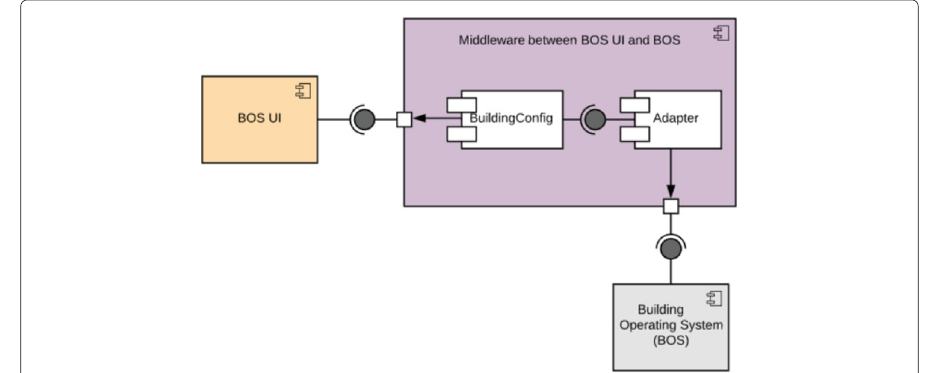
Fig. 26 The component diagram of the middleware between the BOS UI and a